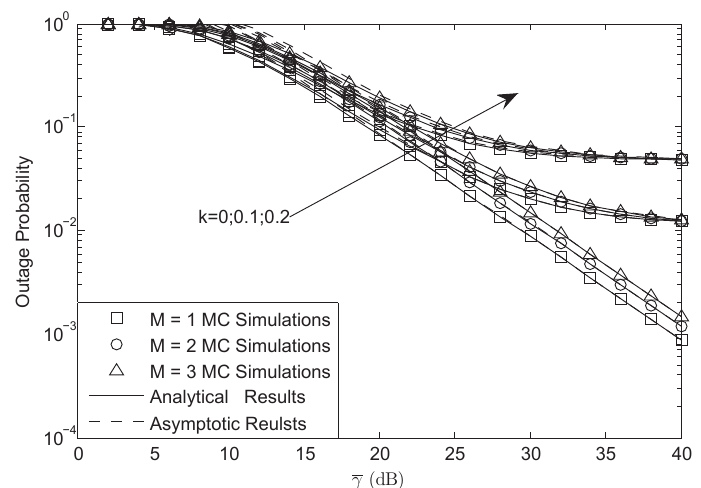
Figure 2. OP of the system versus different γ with σ = 0.8, L = 10 and γ 0 = 3 dB: FHS.